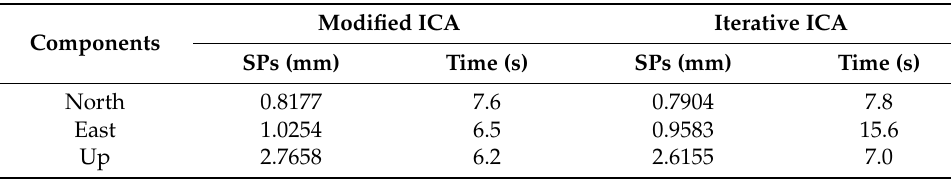
Table 1. Signal power (SP) and time-consumption of modified ICA and iterative